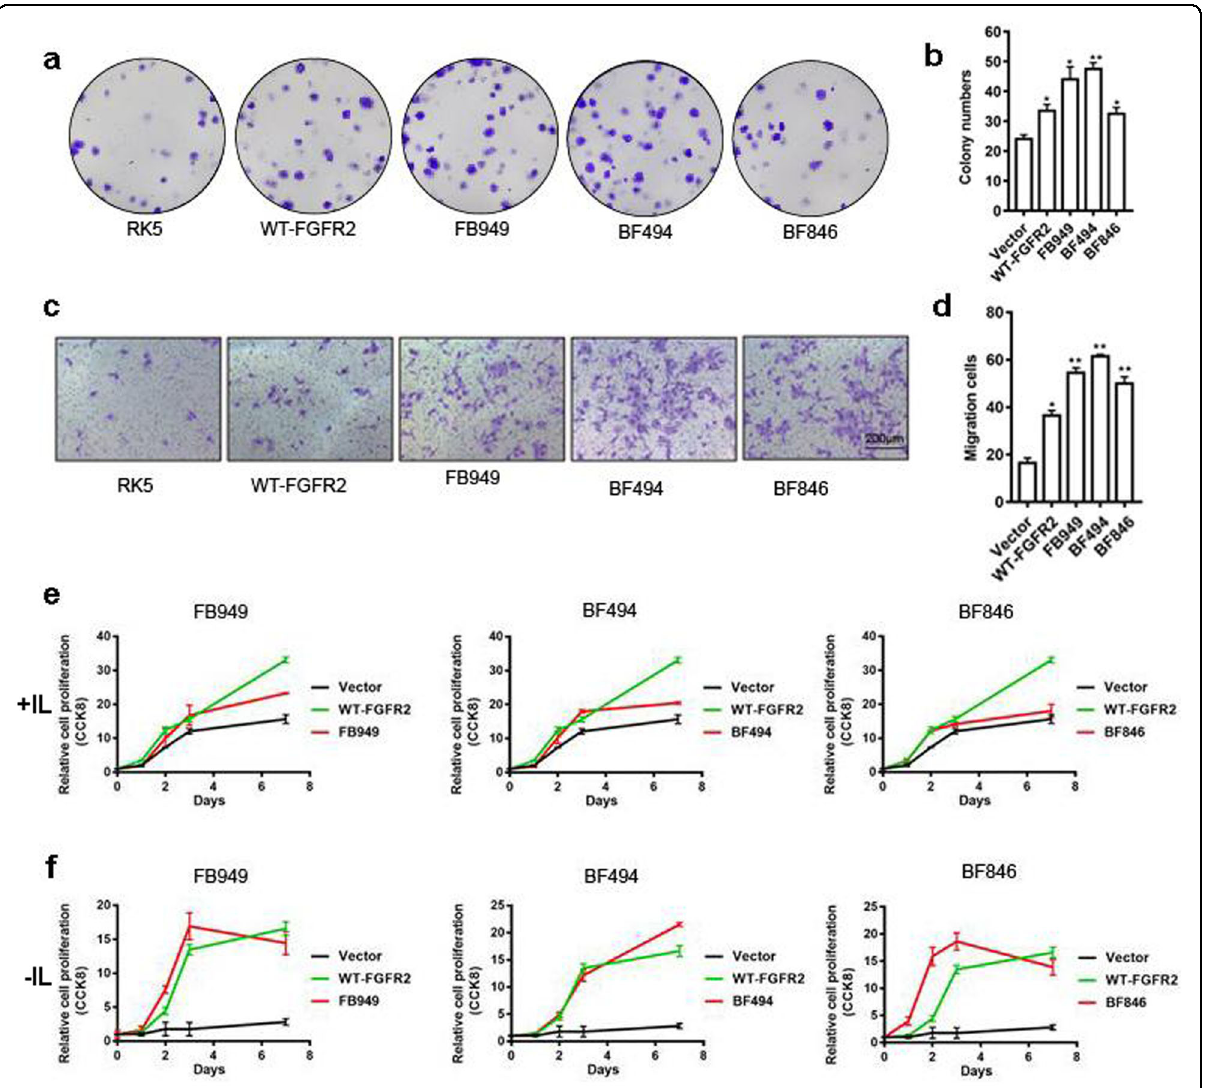
Fig. 4 Proliferation and transformation activity of FGFR2 fusions. Representative images of colonies expressing different FGFR2 fusions in NIH3T3 cells are shown ( a ). Average colonies with different FGFR2 fusions are plotted ( b ). Representative images of transwell migration expressing different FGFR2 fusions in RBE cells are shown (scale bar = 100 μ m) ( c ). Average numbers of migrated cells with FGFR2 fusions are plotted ( d ). Ba/F3 cell growth curve with ( e ) or without IL3 ( f ) are shown. * p < 0.05, ** p <